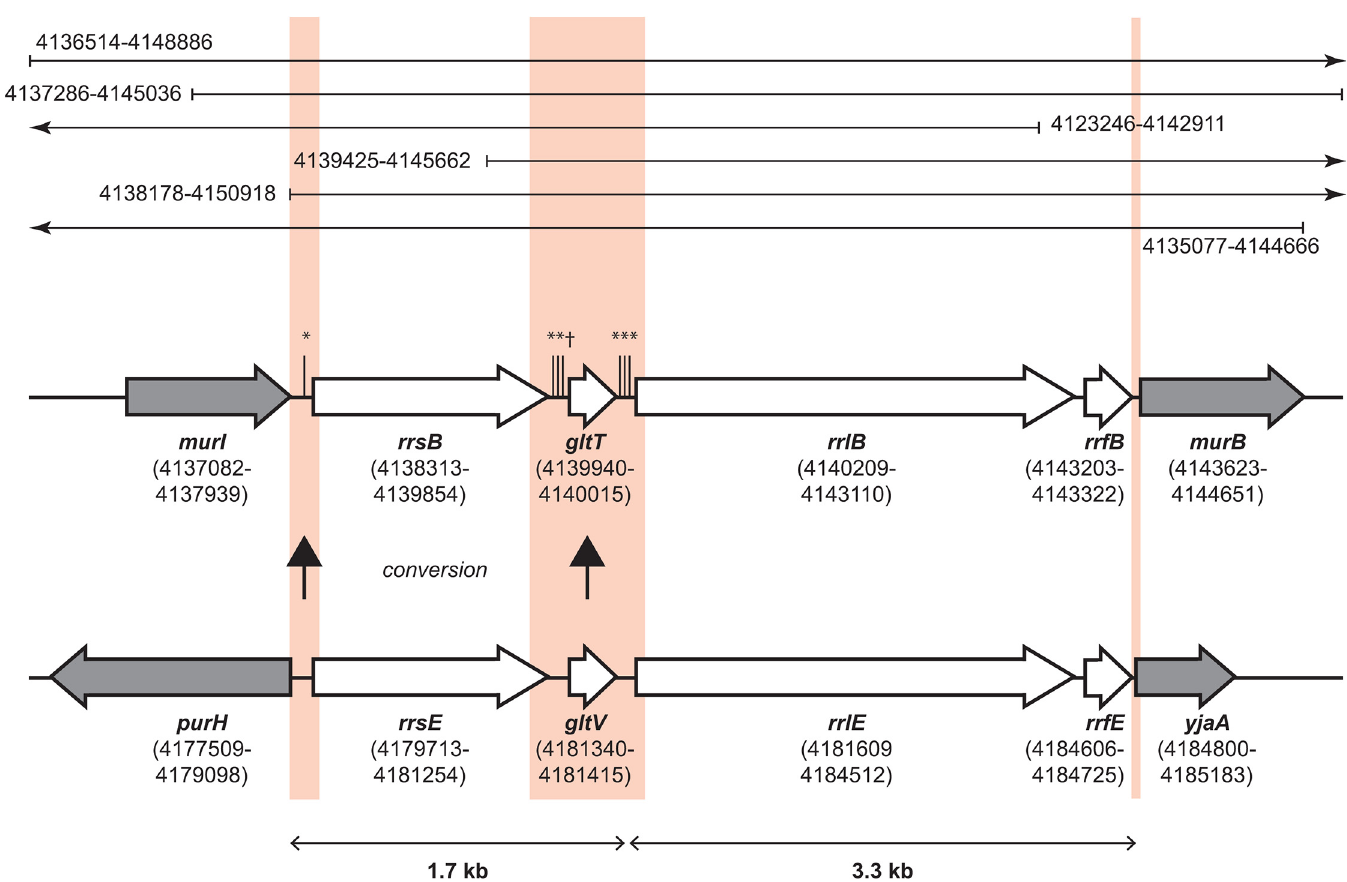
Fig 5. Use of long reads to identify gene conversion events. The schematic alignment shows the paralogous ribosomal gene clusters rrnB and rrnE from ER2796 (white genes) along with nonhomologous flanking genes (gray). The genes are marked with names and coordinates in ER2796. In ER2796, rrnB has been the apparent recipient of a gene conversion event in which rrnE served as donor (vertical arrows), and thus both regions are identical. As a result of this event, rrnB in ER2796 exhibits minor variations when compared with rrnB from its ancestor, MG1655: six SNPs (marked with * ) and one indel (marked with † ). Red tinted boxes indicate the regions of alteration (left and middle) and delineate the boundaries of the clusters (left and right). Sequencing reads internal to the clusters (i.e., between the outer two red boxes) cannot be mapped uniquely to one locus or the other unless they extend into the nonhomologous flanking regions, and the minor variants within (e.g., the middle red box) cannot be assigned to one cluster or the other without sequencing reads directly connecting them with a flanking region on one side or the other. The long-read library used in this analysis includes numerous reads that connect the unique flanking regions with the internal variants. The mapped coordinates of six example reads from the actual analysis are shown at the top, including some that span both sides of the 5 kb gene cluster. Arrows indicate where a read continues beyond the region shown